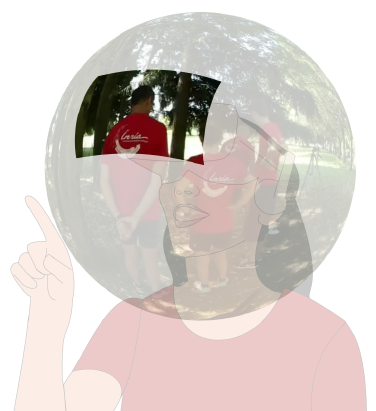
Figure 5. In many applications, including AR/VR/XR and 360-degree video, users are interested in watching a part of a scene (non-shaded area) known as viewport and can freely navigate in the scene enjoying an up to a 6 degree of freedom (DoF) experience.